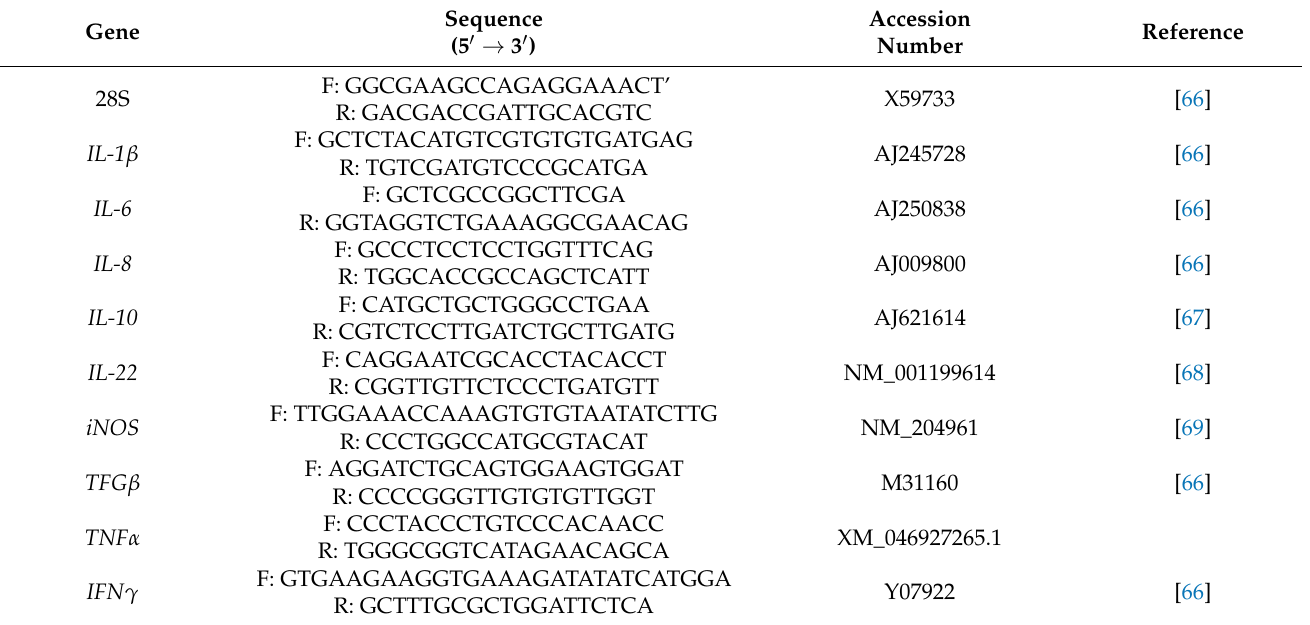
Table 6. List of primers for real-time